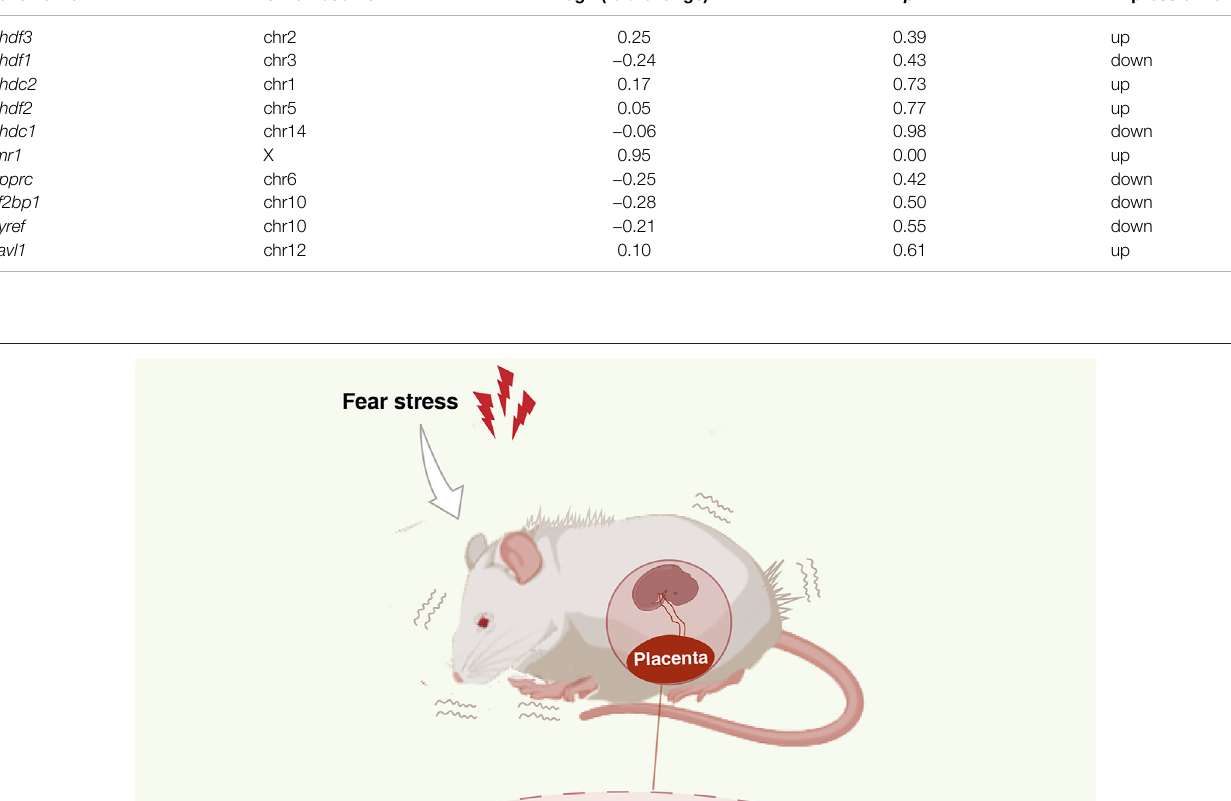
Frontiers in Genetics |